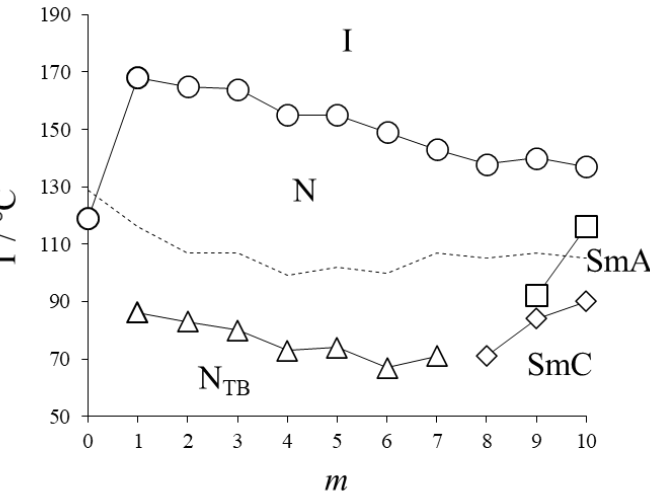
Figure 9. The dependence of the transition temperatures on the number of carbon atoms, m , in the terminal chain for the CBO5O. m series [18]. The broken line joins the melting points. Circles denote T NI ; triangles T NTBN ; squares T SmAN ; diamonds T SmCSmA .